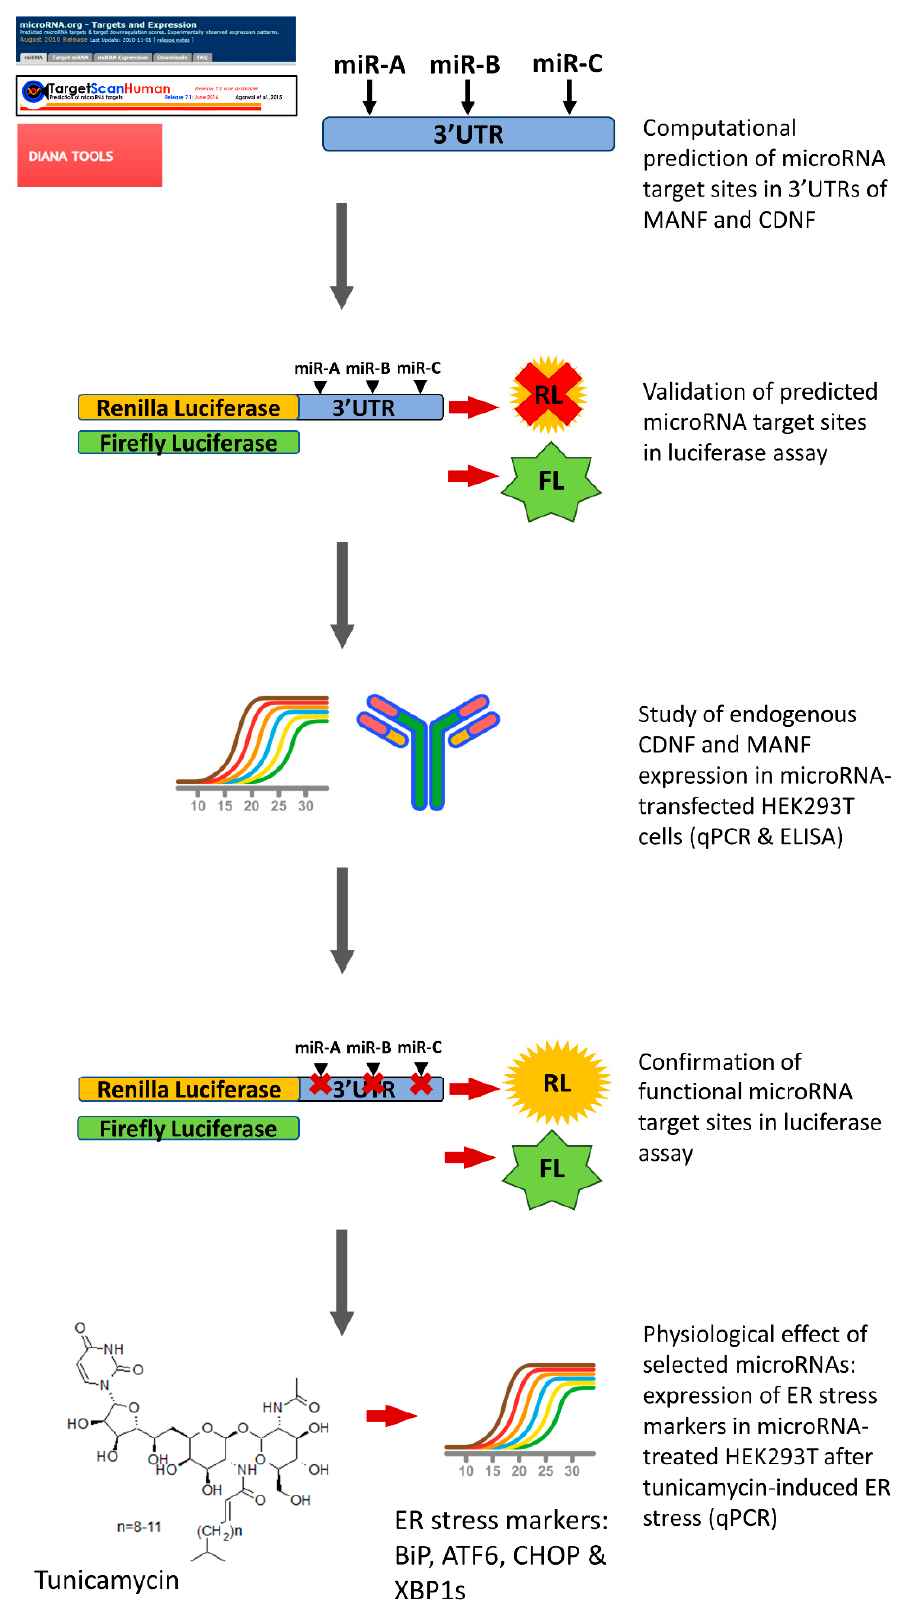
Figure 1. Experimental workflow of the study. Ability of miRNAs to regulate expression of MANF and CDNF was tested using bioinformatic tools, reporter assay and analysis of endogenous protein with qPCR and ELISA. In addition, physiological effect of selected miRNAs was tested with qPCR.